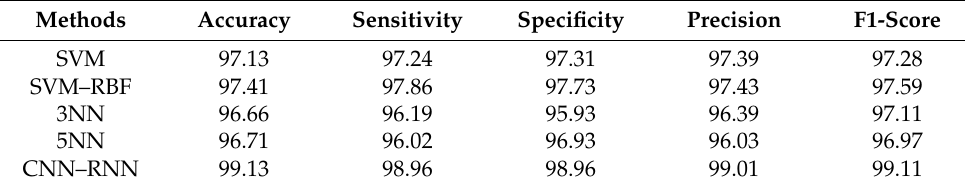
Table 7. Results for the Fribourg